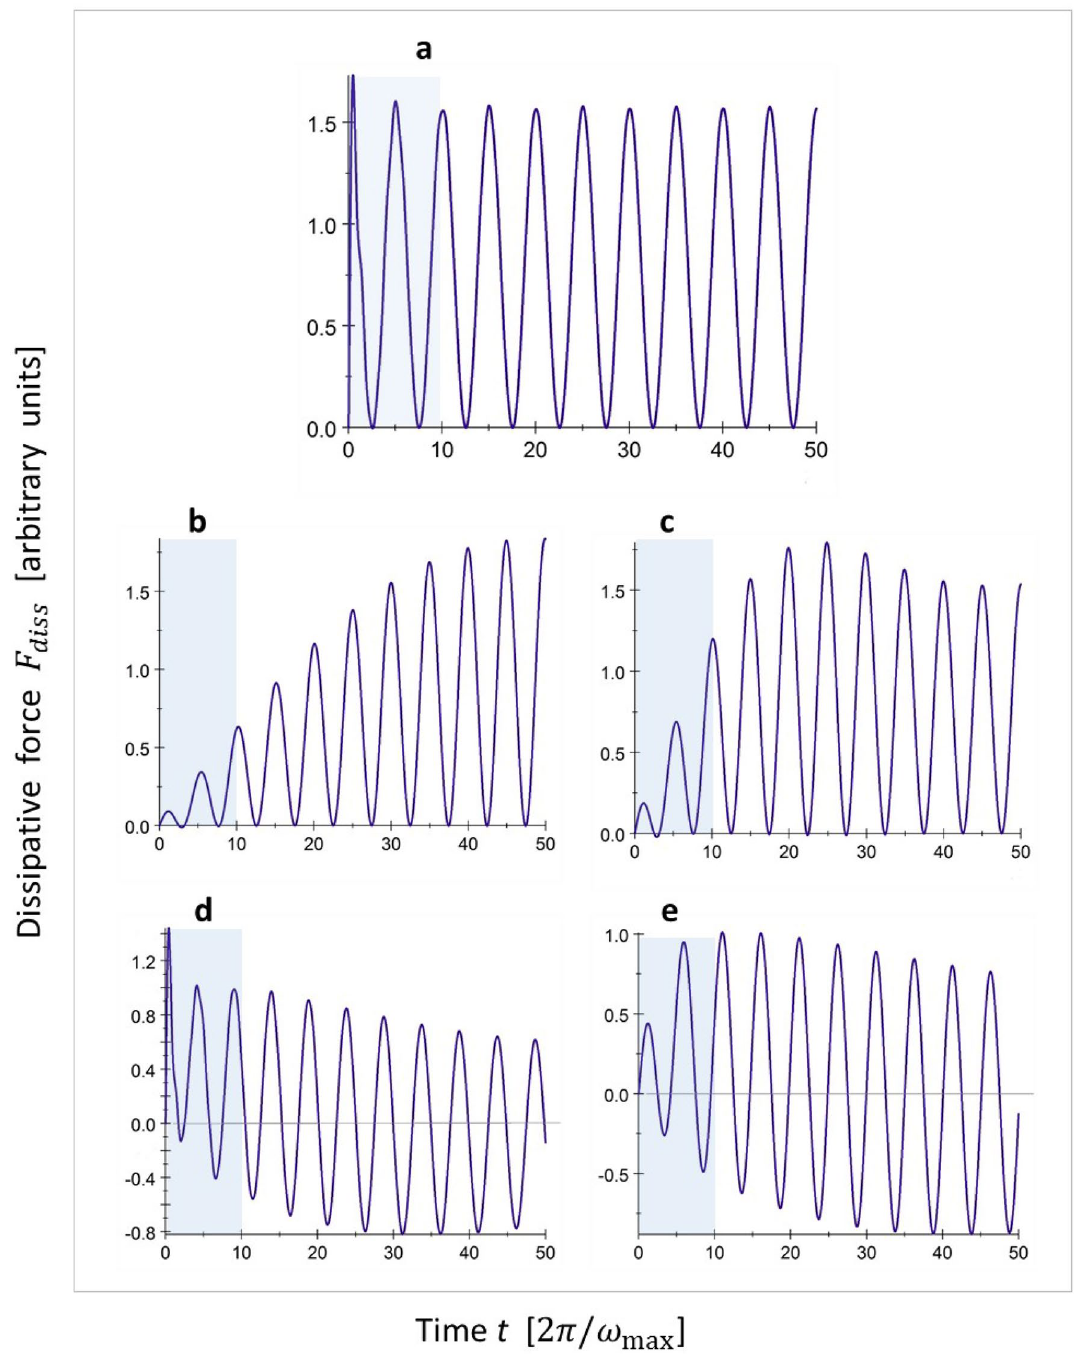
Figure 2. Dimensionless dissipative force (in arbitrary units) as a function of time (expressed in units of the shortest phonon period, 2 π/ω max ) for a particle sliding at constant velocity over an infinitely large, harmonic solid; positive values correspond to dissipation. In this example, the particle velocity is 10% of the velocity of sound, so that the washboard frequency is 0.10 ω max . ( a ) Shows the result of integration over all phonon frequencies, from 0 to ω max . The other panels correspond to contributions of particular phonon frequency ranges: a narrow range of frequencies within ± 10% around the washboard frequency 2 π v / a ( b ), a wider range of ± 20% ( c ), and the upper ( d ) and lower ( e ) ranges complementary to the frequency range of ( c ). The first washboard period (the first lattice period passed by the particle) is marked in